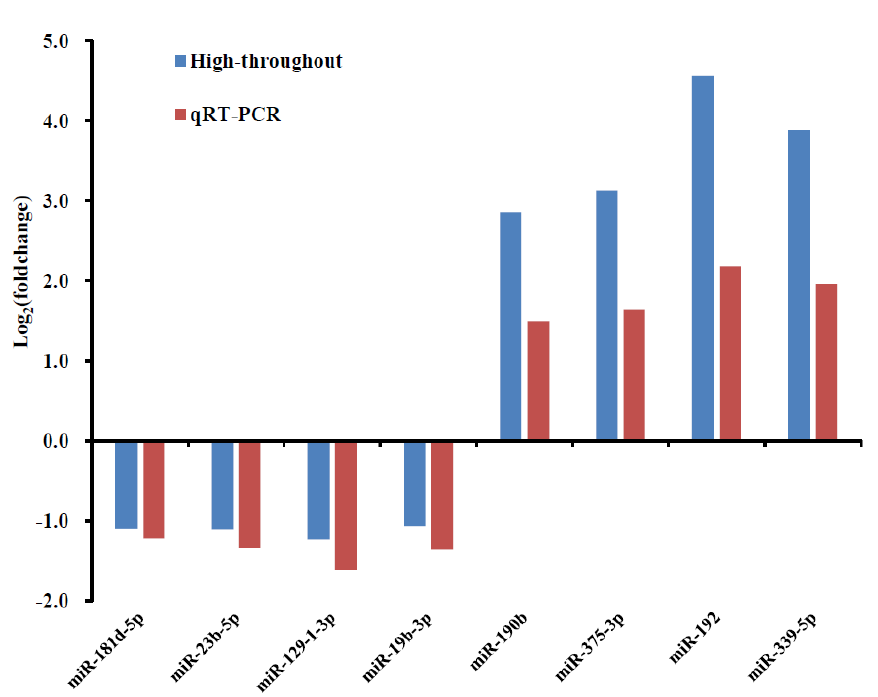
Figure 2. Alterations in the miRNA profiles in H 2 O 2 treated PGCs. ( A ) The heat map of 22 DEmiRNAs between low-concentration group (LOS) and normal control (CON). The color scale of the heat map ranges from blue (low expression) to red (high expression). ( B ) The heat map of 33 DEmiRNAs between high-concentration group (MOS) and normal control (CON). Low-concentration group (LOS): 100 μM H 2 O 2 ; high-concentration group (MOS): 300 μM H 2 O 2 ; ( C ) DE miRNAs with high fold changes were chosen for qRT-PCR validation. Dates were normalized using the U6 gene. The data are presented as mean ± S.E. ( n = 3). The values are shown as log2 (fold change).